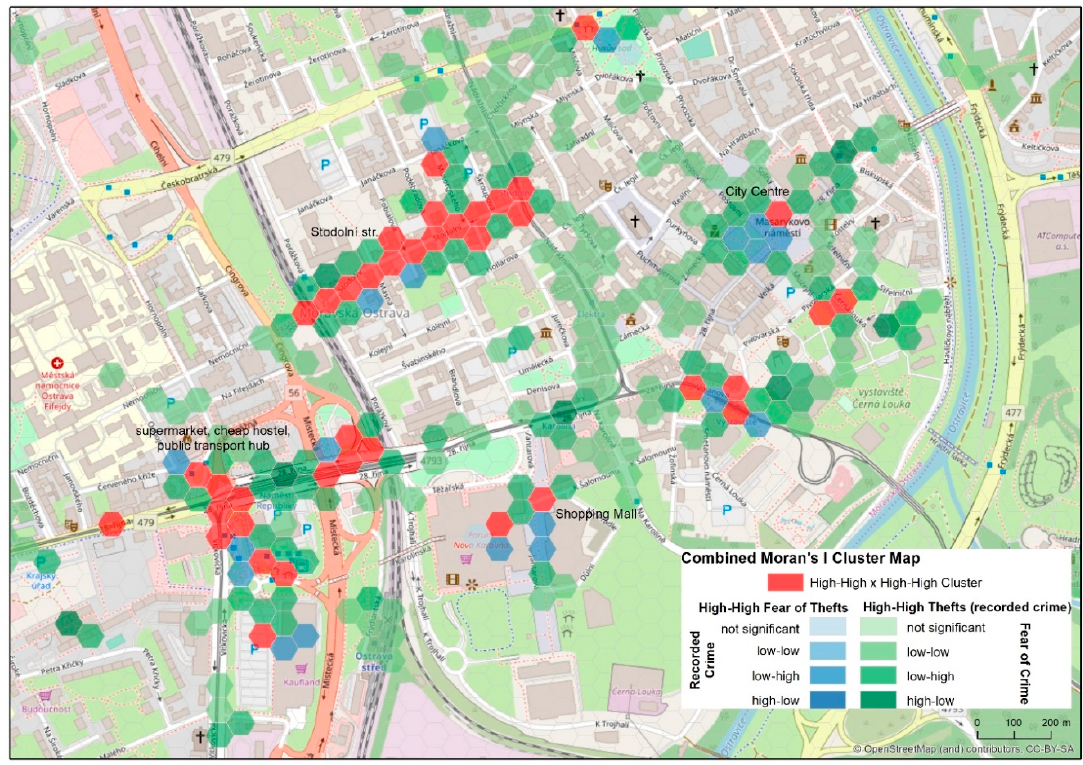
Figure 4. Cluster map comparing the fear of personal thefts and thefts as recorded crime incidents.